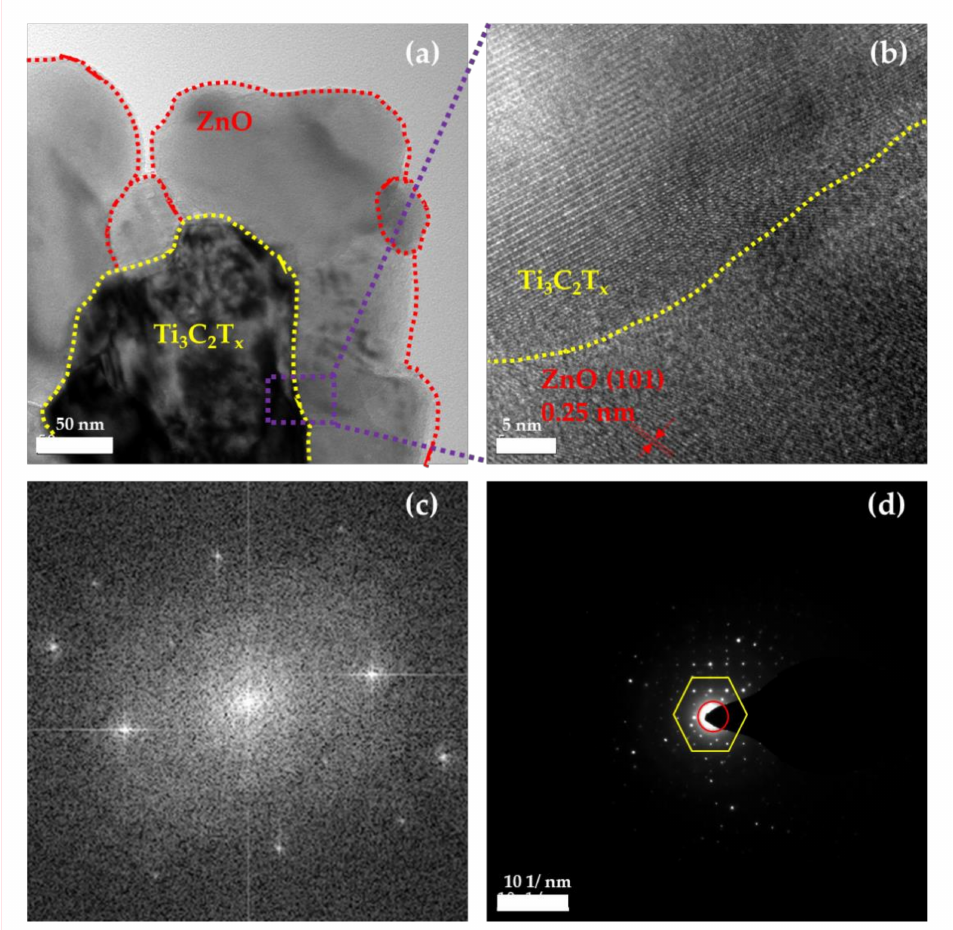
Figure 3. ( a , b ) HR-TEM images, ( c ) FFT pattern, and ( d ) SAED pattern of a ZnO / Ti 3 C 2 T x hybrid